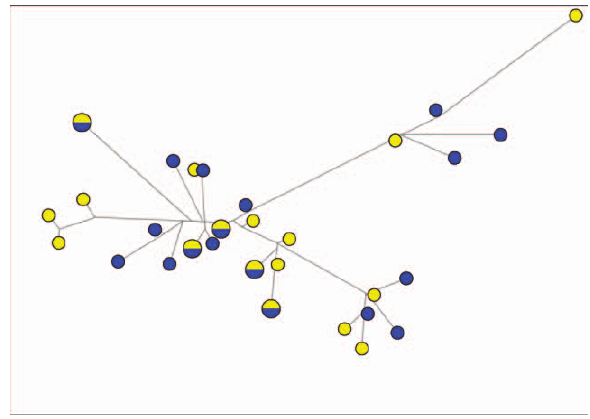
Figure 3. The median joining network of 30 haplotypes in Guangxi and Hainan populations. Circles denote haplotypes unique to Guangxi (yellow), or unique to Hainan (blue), or in both Guangxi and Hainan (half yellow and half blue). The sizes of circles are